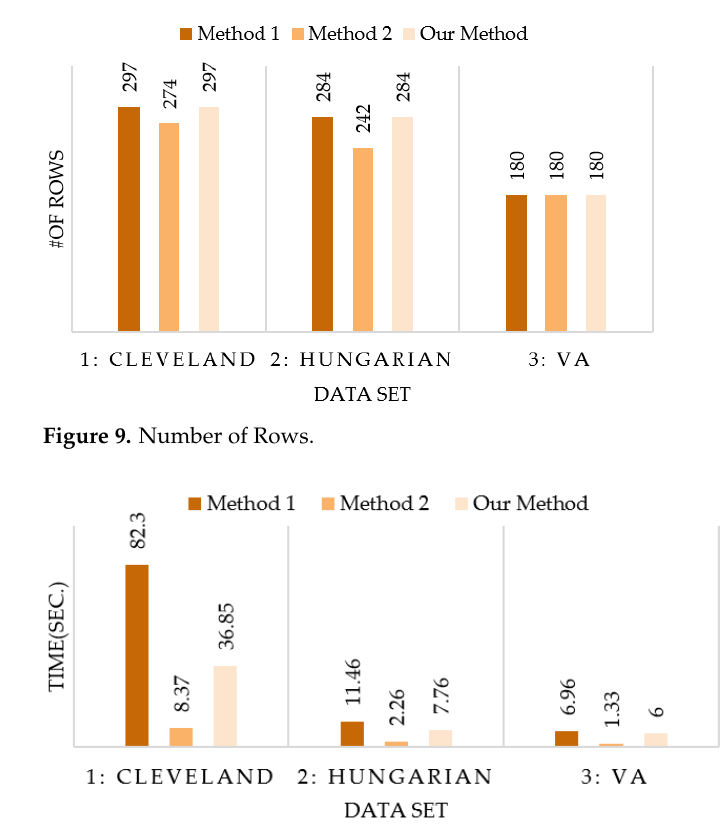
Figure 10. Total Time in Seconds.